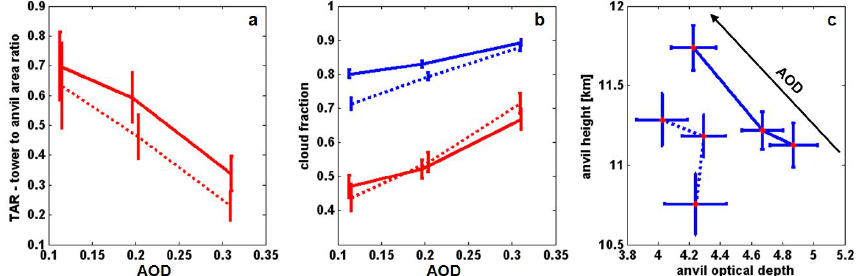
Fig. 8. Same analysis as shown in Fig. 3, but dividing the data into two meteorological regimes defined as either large scale rising motion (negative pressure vertical velocity, ω) and denoted as solid curves, or subsidence (positive ω) shown as dotted